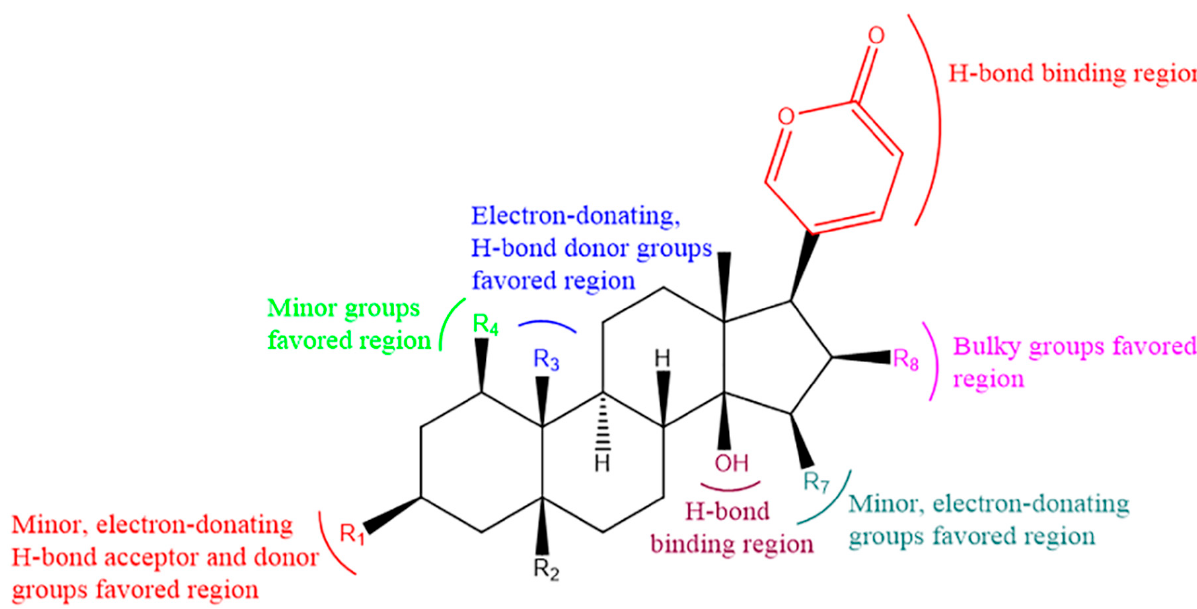
Figure 5. Structure–activity relationship of bufadienolides revealed by 3D-QSAR study.